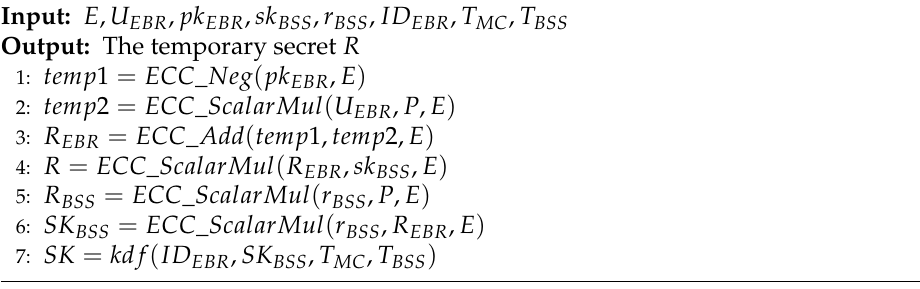
Algorithm 2 BSS calculates SK = kd f ( ID EBR , SK BSS , T MC , T BSS